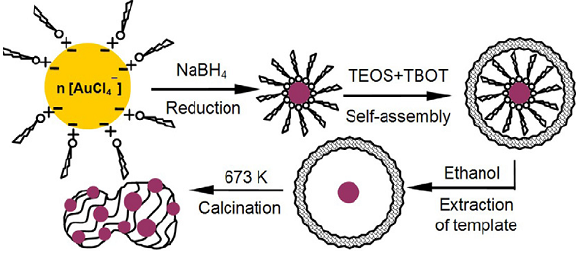
Figure 11. Synthesis of Au/Ti-HMS by in situ -reduction. Reproduced with permission from [42]. Copyright 2011 Elsevier B.V.